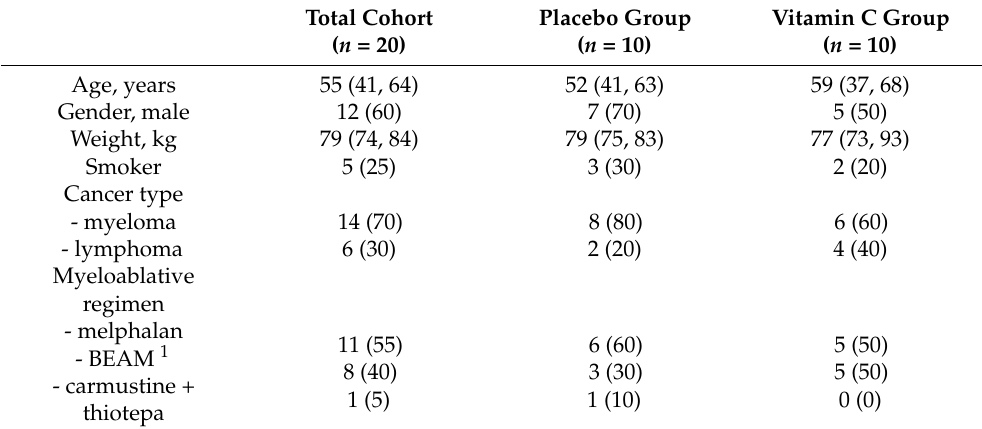
Table 1. Participant characteristics at baseline.